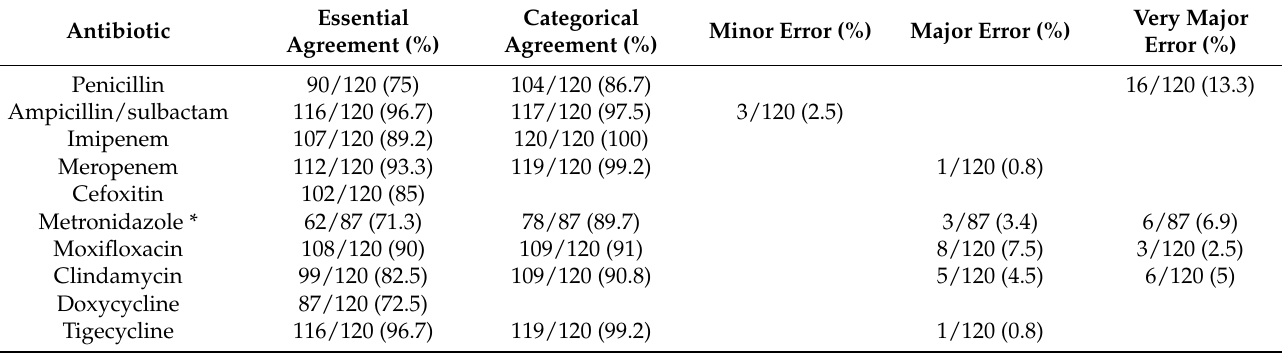
Table 3. Comparison of the results obtained by agar dilution method and by E-Test